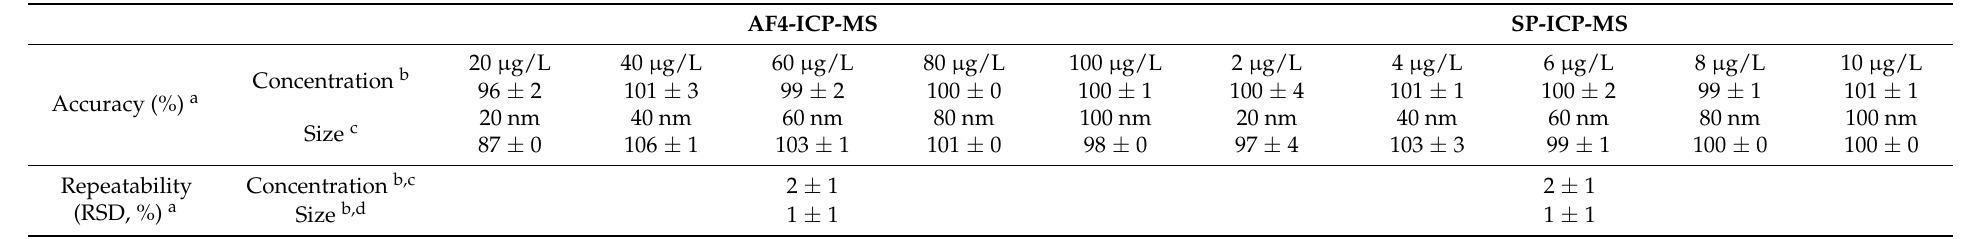
Table 2. Evaluation of accuracy and repeatability in measurement of concentration and size of AgNPs in milk by AF4-ICP-MS and